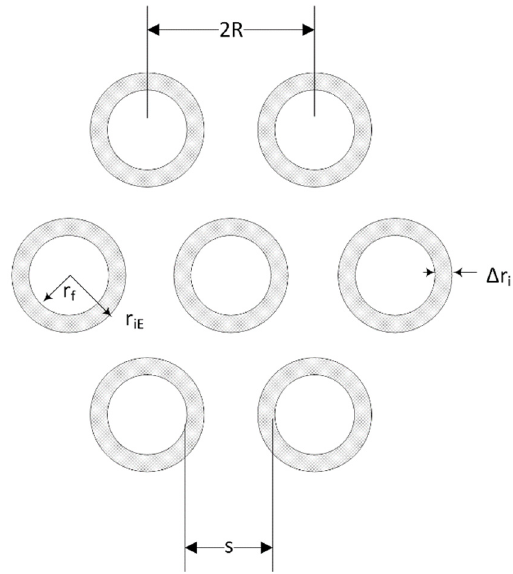
Figure 2. Hexagonal array of fibers in a unidirectional fiber composite. Fibers are surrounded by an interphase area.